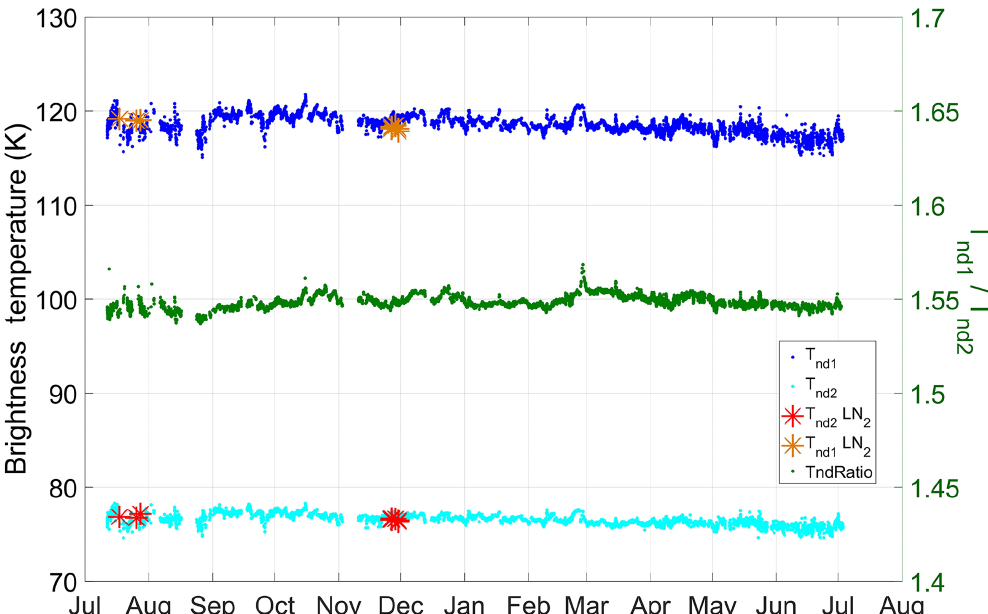
Figure 4. Time series of the noise diodes mean emission temperature calculated by means of the tipping curve procedure (blue and cyan solid circles) compared with values obtained by means of LN 2 calibrations (orange and red stars). The green dots and the right y axis display the ratio of the emissions from two noise